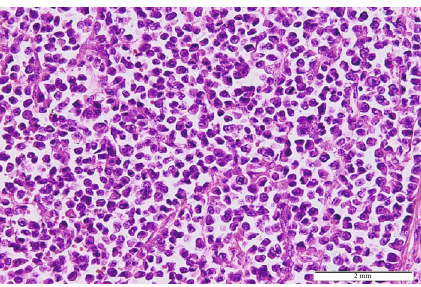
Figure 3: High-power examination reveal pleomorphic nuclei, clear to eosinophilic cytoplasm, and abnormal mitotic fi gures ( H&E × 100